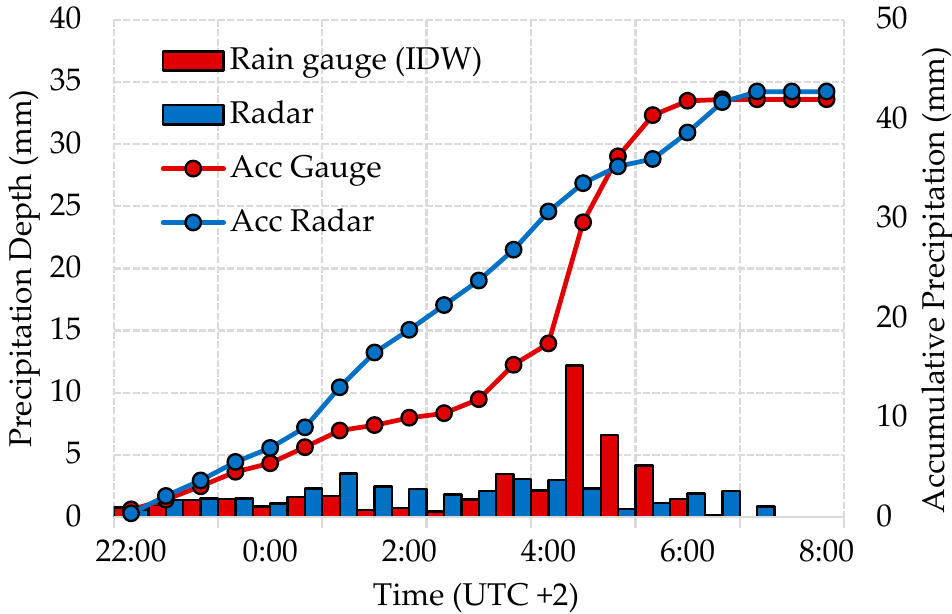
Figure 4. Mean areal precipitation and accumulative precipitation (Acc) for the rain gauge and radar estimations through the IDW and Z = 200 R 1.6 precipitation products.